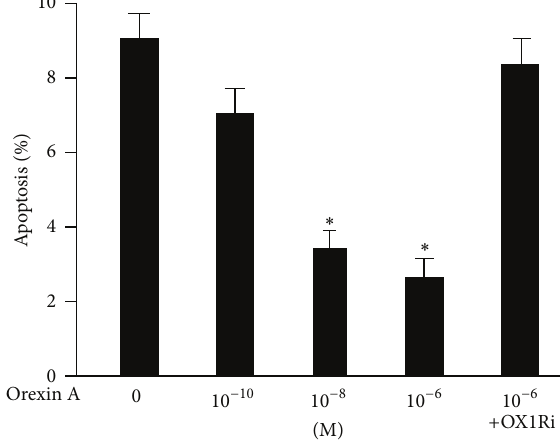
Figure 3: OXA protects INS-1 cells from apoptosis. Cells were exposed to OXA at concentrations of 0M, 10 −10 M, 10 −8 M, and 10 −6 M for 24 h, or cells treated with 10 −6 M OXA in the presence of the OX1R antagonist SB334867 (OX1Ri) (10 −6 M). Apoptosis was assessed with flow cytometry using Annexin V-FITC and PI. Data are presented as mean ± SEM based on triplicate determinations from a representative experiment. Asterisks indicate significant differences compared to control ( ∗ 𝑃 < 0.05) .